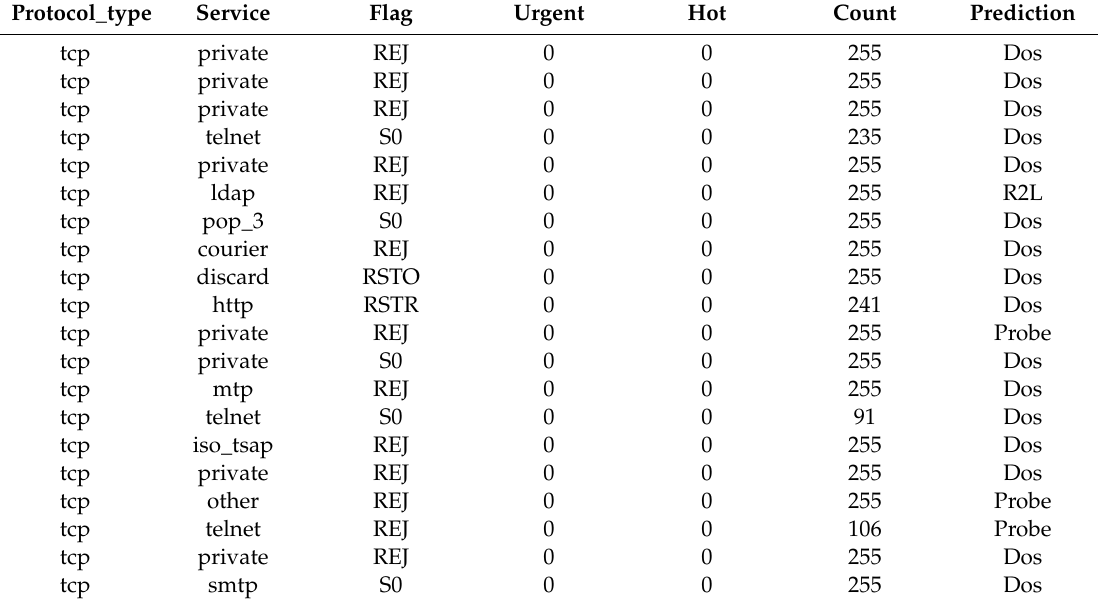
Table 12. Some of the generated